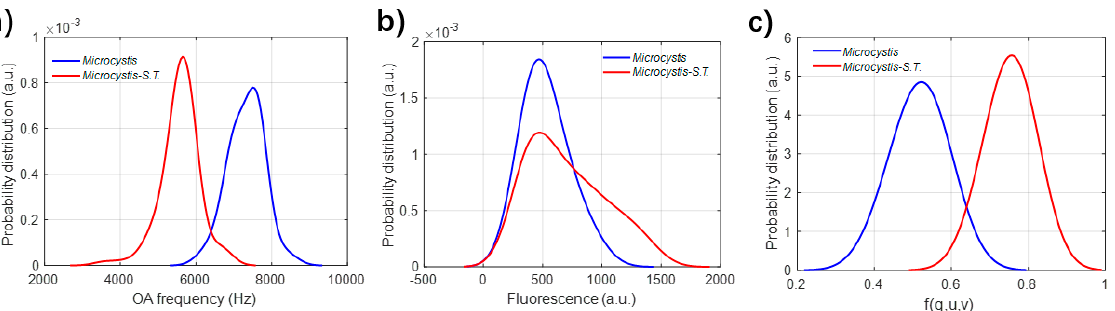
Figure 7. ( a – c ) Statistical probability distribution of different parameters. ( a ) Frequency of optoa- coustic signal; ( b ) Fluorescence; ( c ) Projected polarization parameter 𝑓(𝑞, 𝑢, 𝑣) .